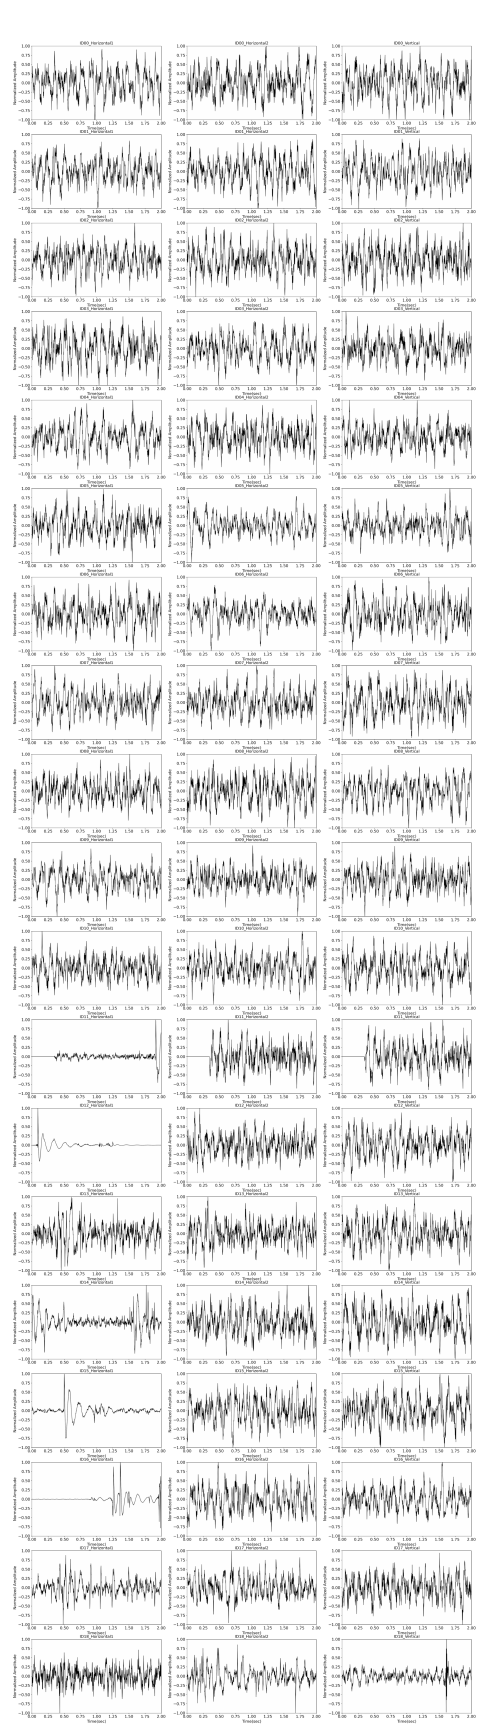
Figure A2. Noise test samples (horizontal 1, horizontal 2, and